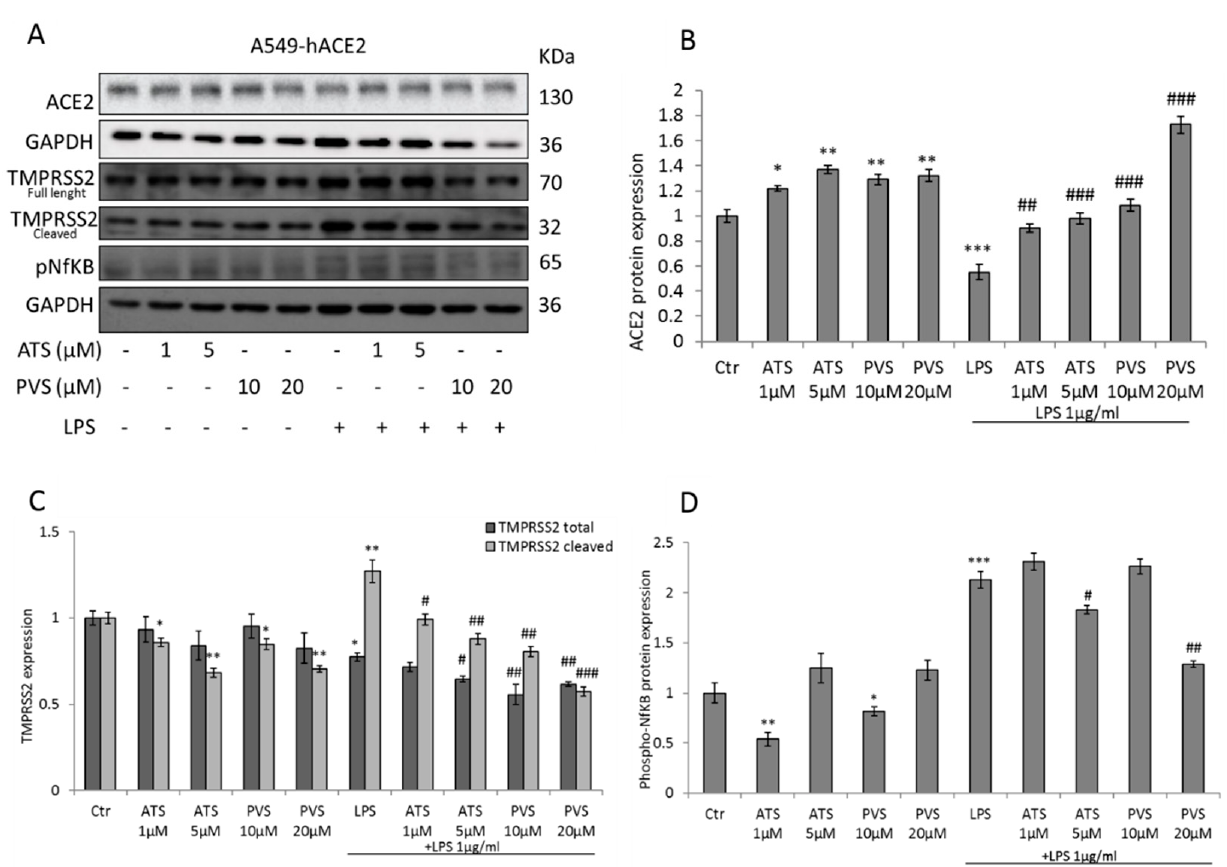
Figure 2. Representative Western blot and densitometric analyses of ( A , B ) ACE2 receptor, ( A , C ) TMPRSS2 (total and cleaved forms) and ( A , D ) phosphorylated-NfKB expression in A549-hACE2 cells treated with ATS and PVS, alone or after stimulation with LPS as indicated. GAPDH was used as loading control. Data are expressed as mean ± SD of at least three independent experiments. * p < 0.05, ** p < 0.01, *** p < 0.005 vs. control. # p < 0.05, ## p < 0.01, ### p < 0.005 vs. LPS alone.